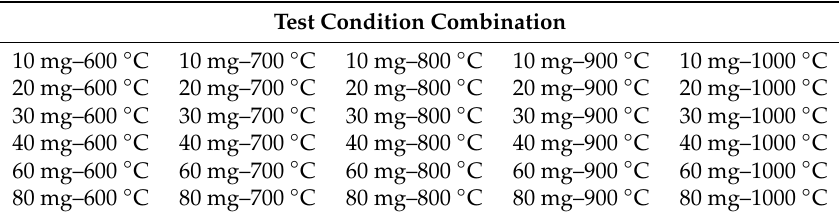
Table 5. Test conditions for swelling characteristics.